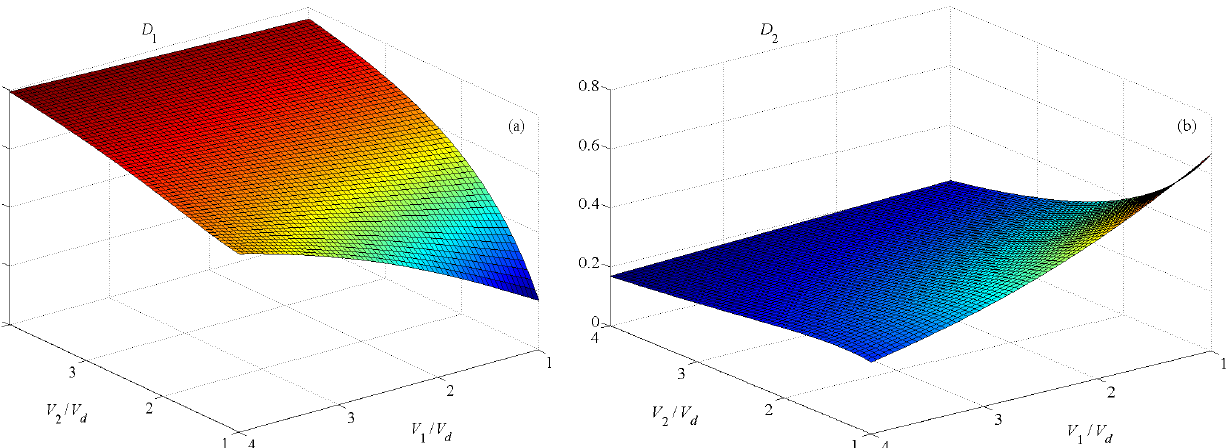
Figure 8. Duty cycles of switches as a function of desired output voltage. ( a ) D